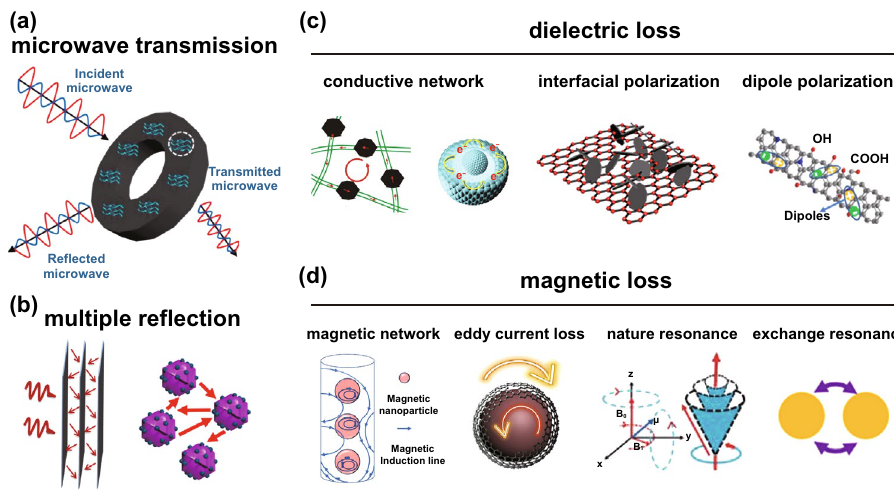
Fig. 3 a Illustration of the microwave absorption mechanism, including microwave transmission path, b multiple reflection inside the MAMs, c dielectric loss (conductive network, interfacial polarization and dipole polarization) and d magnetic loss (magnetic coupling network, eddy cur- rent loss, nature resonance and exchange resonance). Reprinted with permission from Refs. [40,